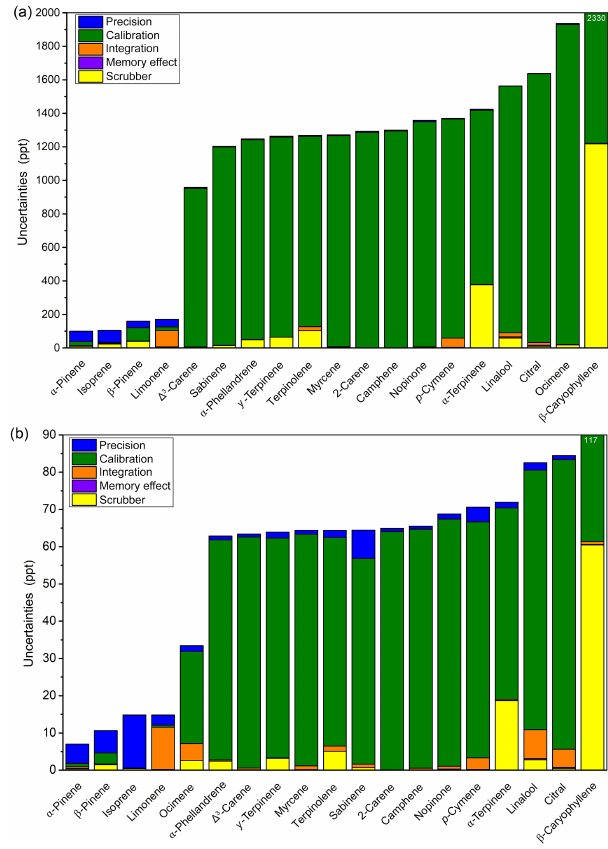
Figure 7. Repartitioning of uncertainties for the five terms consid- ered (precision, calibration, integration, memory effect, and scrub- ber) at (a) 2ppb and (b) 100ppt with laboratory analytical parame- ters.